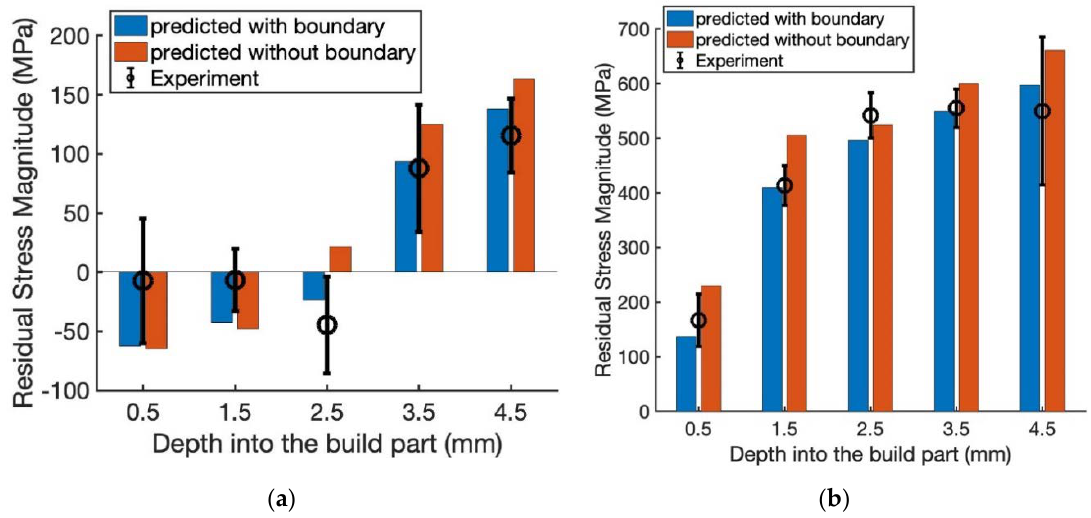
Figure 7. Predicted and measured residual stress of IN718 sample built via L-PBF with the laser power of 150 W and scan speed of 600 mm / s, layer thickness of 30 µ m, and hatching space of 100 µ m: ( a ) along the scan direction; and ( b ) along the build direction.